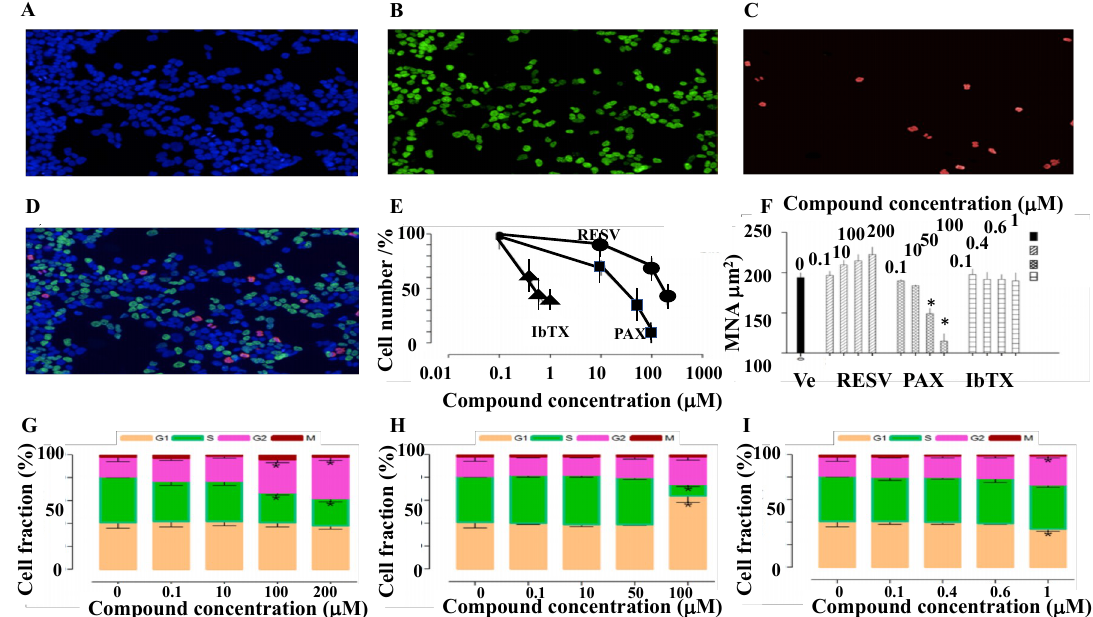
Figure 3. High-content cell-cycle analysis. ( A – D ) Example images of vehicle (DMSO 1.7 × 10 −1 %)-treated SH-SY5Y cells stained with ( A ) NuclearMask Blue Stain, and ( B ) Alexa Fluor 488 (green, S-phase cells), or ( C ) anti-pHH3 (red, M-phase cells) antibodies are shown. ( D ) Merged image from panels ( A – C ). The effects of RESV, PAX, and IbTX treatment upon cell number and nuclear area are shown in panels ( E) and ( F ), respectively. Concentration-response cell-cycle modifications by RESV, PAX, and IbTX determined using the multi-parametric approach are shown in panels ( G – I) . Values are the mean ± SD of 5 biological replicates; * p < 0.05 versus vehicle-treated controls (Student’s t -test, two-tailed distribution, two sample equal variance). Operetta high-content imaging system (Perkin Elmer Life Sciences, Boston, MA, USA) was performed using a 20× long working distance objective. Typically, 10 fields per well were imaged which equated to approximately 6000 cells/well.